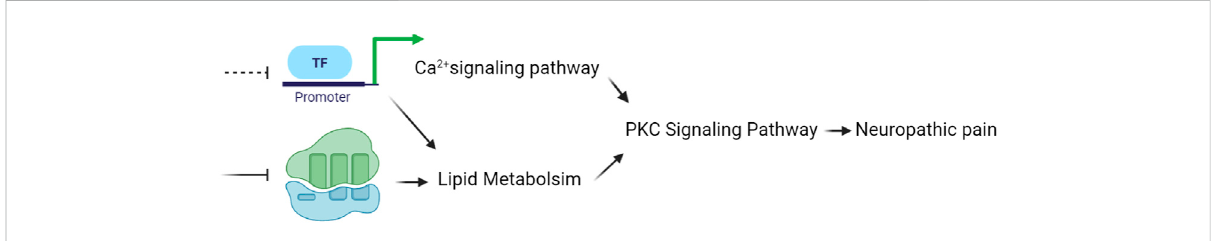
FIGURE 6 Working model of PL. PL may alleviate neuropathic pain by coordinating the calcium signaling and lipid metabolism to suppress PKC signaling transduction. PL, paeoni fl orin and liquiritin